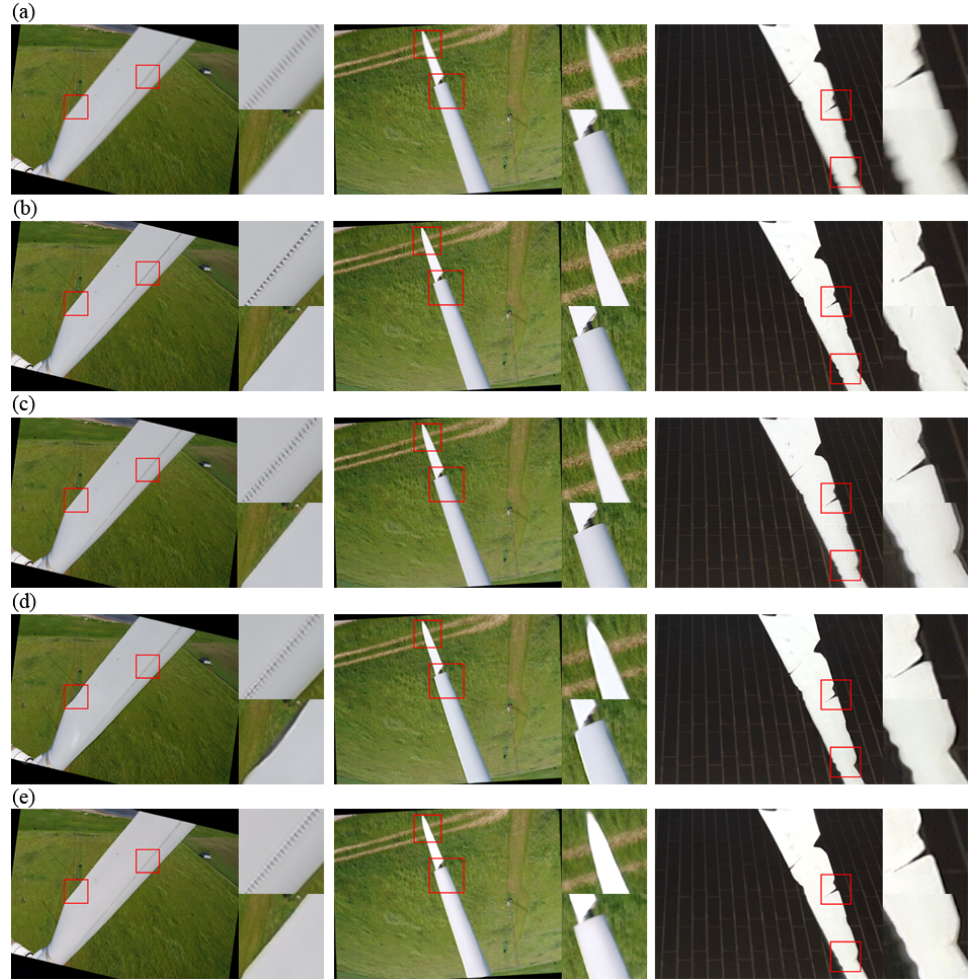
Figure 13. Motion deblurring results for images captured with a rotational angular velocity of 2–4 rad/s (the blur length increases from left to right column): ( a ) Blurred images; ( b ) Sharp images; ( c ) Restored images using the DeblurGAN; ( d ) Restored images using the M-DeblurGANv2; ( e ) Restored images using the I-DeblurGANv2.